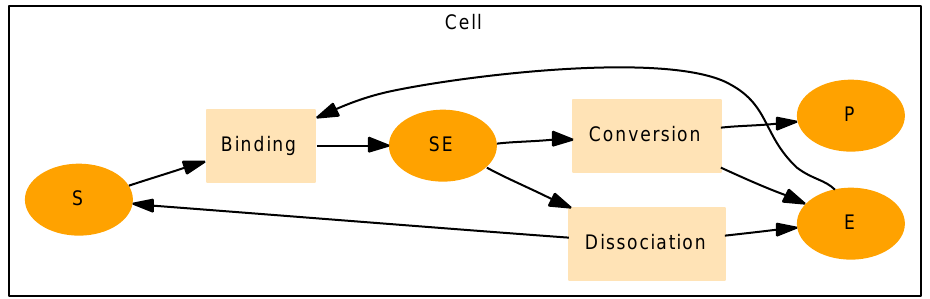
Figure 1: A simple biochemical